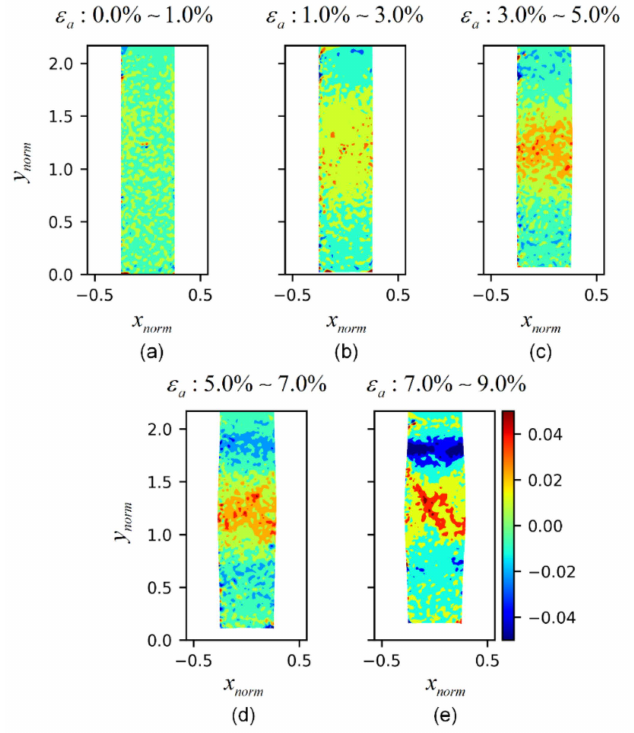
Figure 17. Evolution of divergence field div U of test 121304c: ( a ) axial strain 0.0%–1.0%; ( b ) axial strain 1.0%–3.0%; ( c ) axial strain 3.0%–5.0%; ( d ) axial strain 5.0%–7.0%; ( e ) axial strain 7.0%–9.0%.